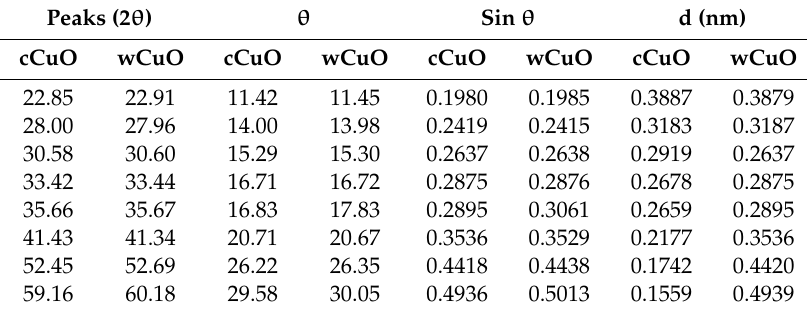
Table 1. d-inter planar spacing calculations for